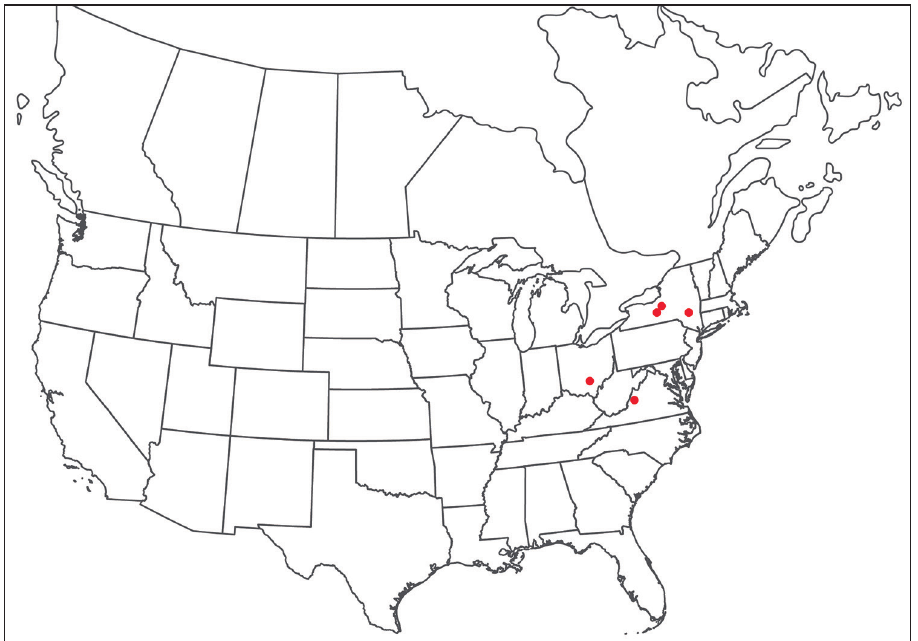
Figure 38. Torrenticola cardia sp. n.